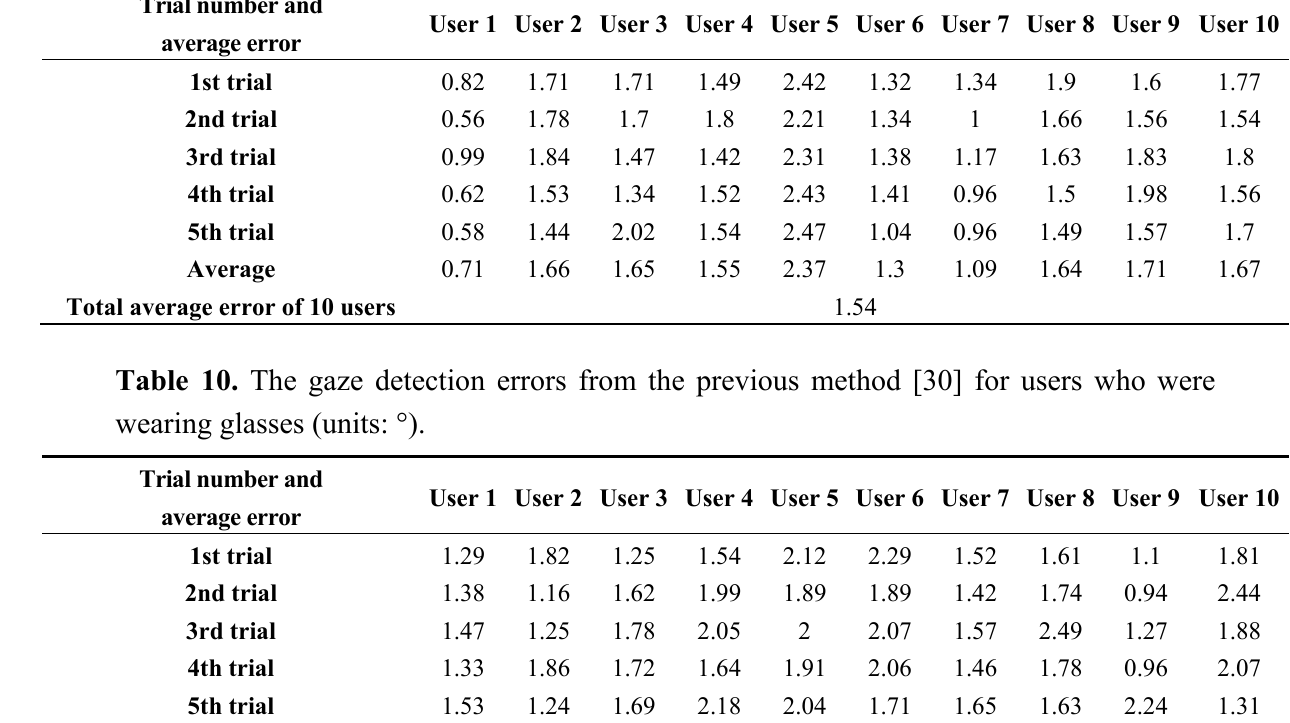
Table 9. The gaze detection errors from the previous method [30] for users who were not wearing glasses (units: °).